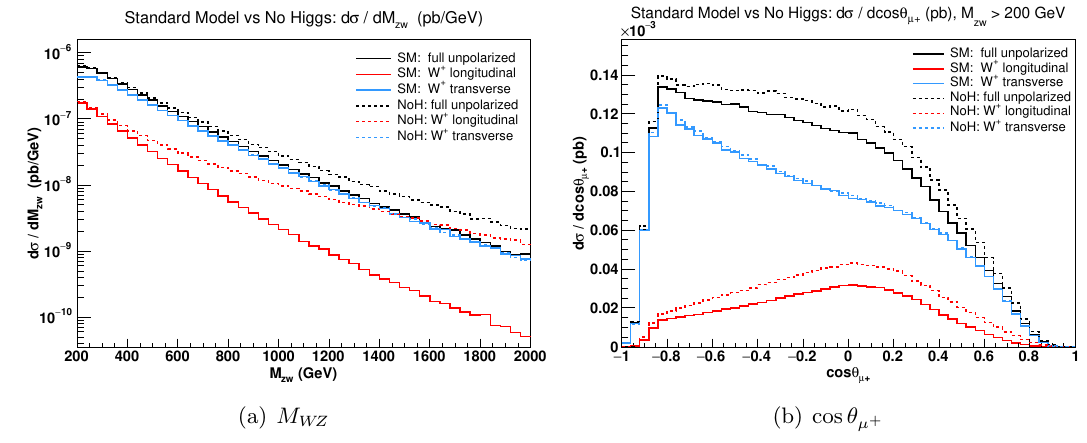
Figure 17 . W + Z scattering: comparison of Standard Model (solid) and Higgsless model (dashed) distributions in M WZ and cos (cid:18) . Polarized distributions concern the W + boson. The full set of (cid:22) + kinematic cuts (see section 5.1) is understood, including lepton and missing transverse momentum cuts, as well as neutrino